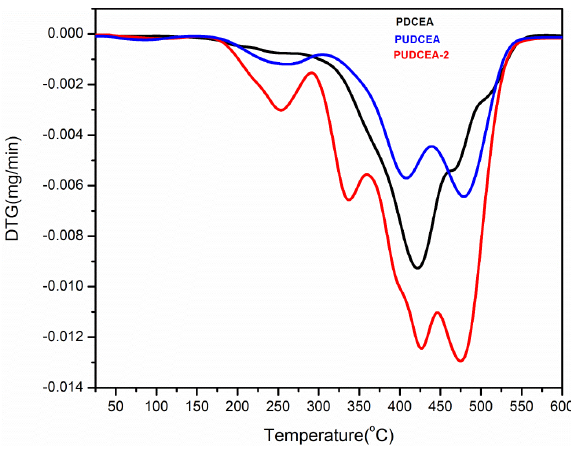
Figure 10. DTG thermogram of PDCEA, PUDCEA and PUDCEA-3.